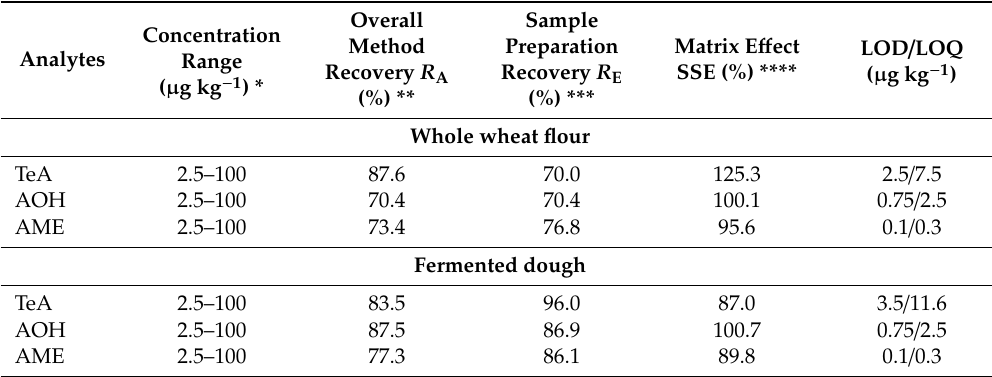
Table 1. Recovery data of the employed analytical method based on solvent ( R A ) and matrix-matched ( R E ) calibration curves and matrix e ff ect